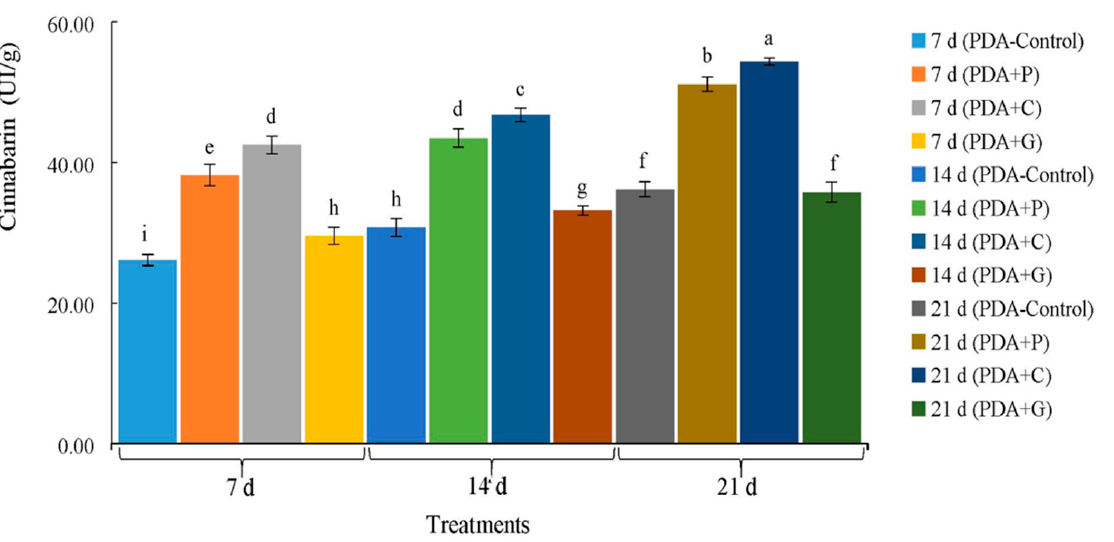
Figure 4. Synthesis of cinnabarin from P. sanguineus in different media at 7, 14 and 21 days. InU = Inhibitory unit = Quantity (mg) that gives an inhibition equivalent to 1 mg of cinnabarin by diffusion assay (Sm â nia et al., 1997). Media followed by the same letter does not present statistically significant differences ( p ≤ 0.05) by Tukey’s test.